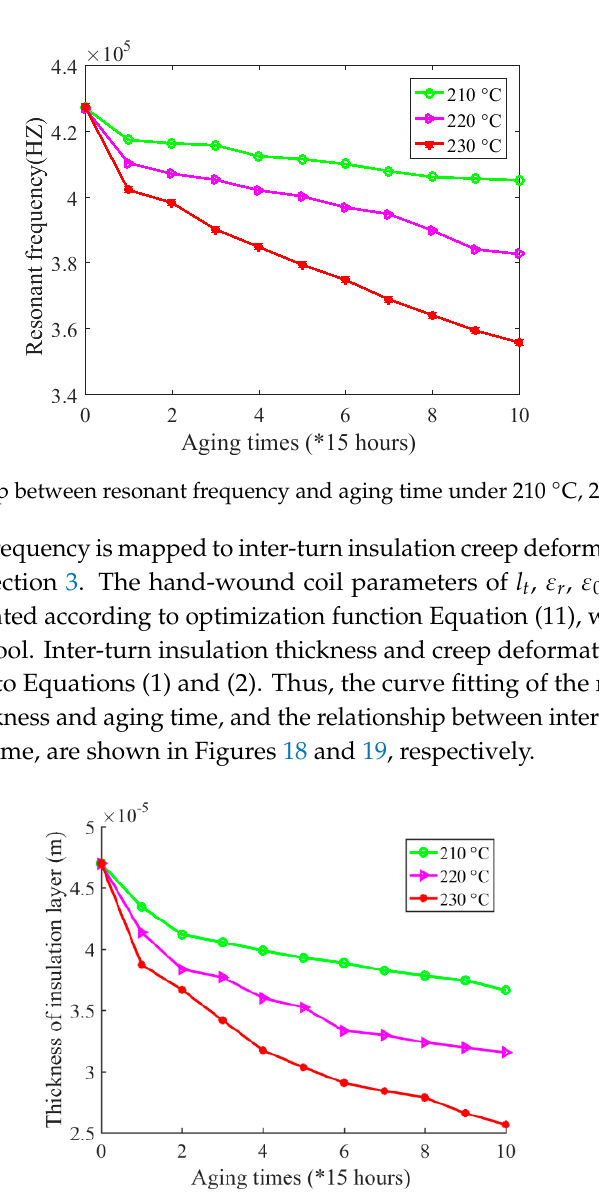
Figure 18. Insulation thickness by calculation based on coil high-frequency electrical parameter under 210 °C, 220 °C, and 230 °C.